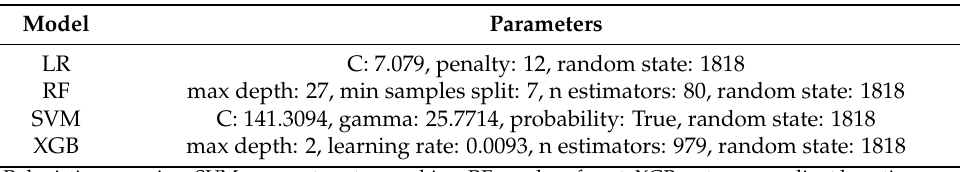
Table 1. Parameters used in the four types of machine learning models.